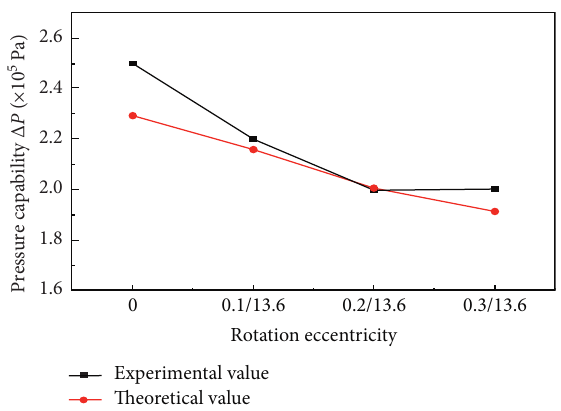
Figure 16: Influence of rotating shaft eccentricity on pressure resistance ability of divergent magnetic fluid